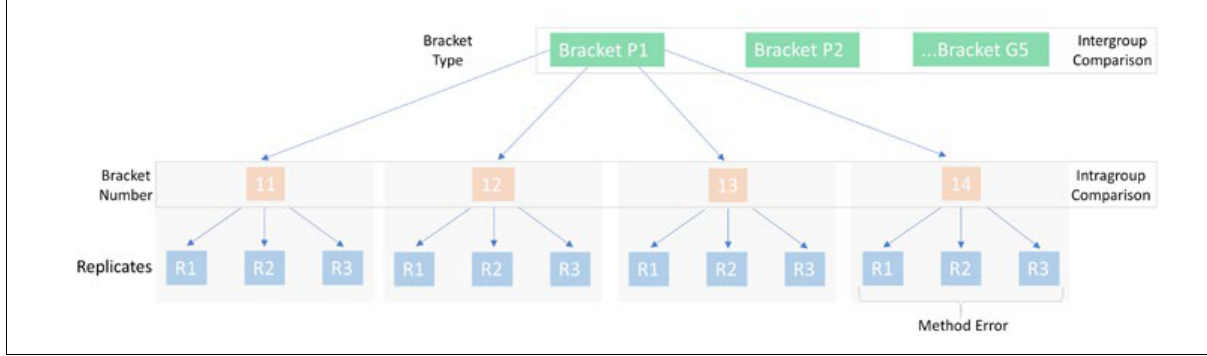
Figure 1. Overview of the experimental design. From each group, the same four brackets from the upper right quadrant were selected (11, 12, 13, 14) and individually analysed. The measurement for each of these brackets was repeated three times to determine the precision of the technique. The average of the triplicate measurements provided the metal composition for each bracket. The average and standard deviation of the measurements from the four brackets from each brand gave the composition and consistency for each group,